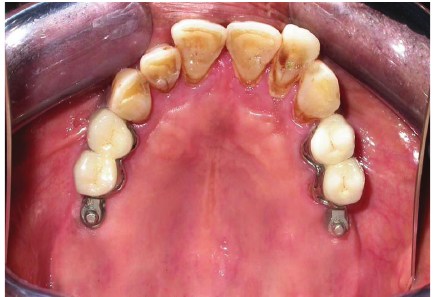
Figure 1: Maxillary arch showing Kennedy’s class 1 situation.